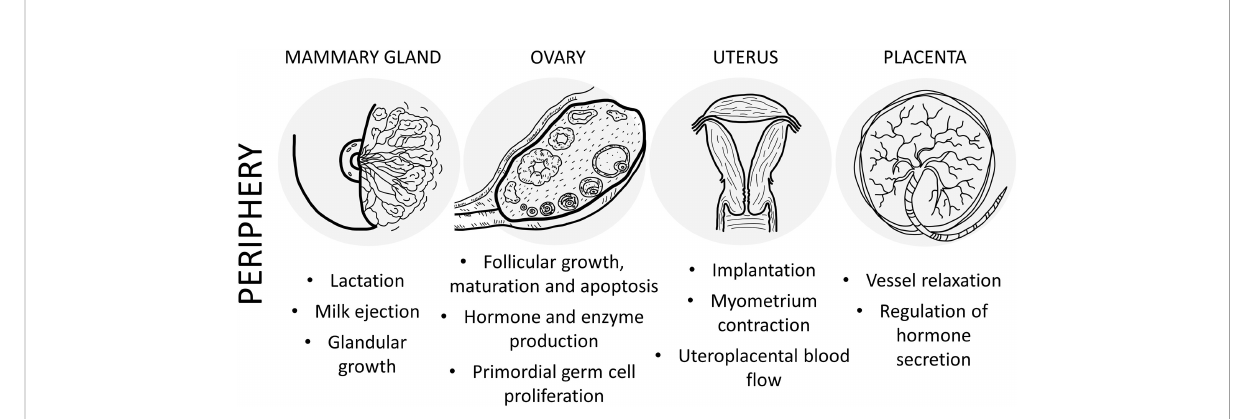
FIGURE 2 Schematic drawing of the main effects of PACAP in the female reproductive system at peripheral